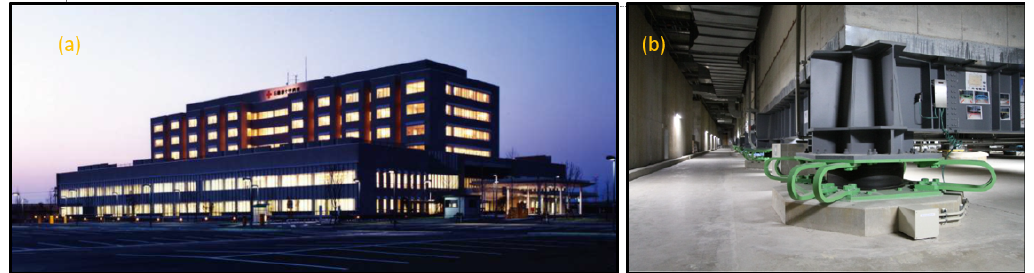
Figure 16. ( a ) Ishinomaki Red-Cross Hospital. ( b ) Japanese compact anti-seismic device (Courtesy of Japanese Society of Red Cross) .